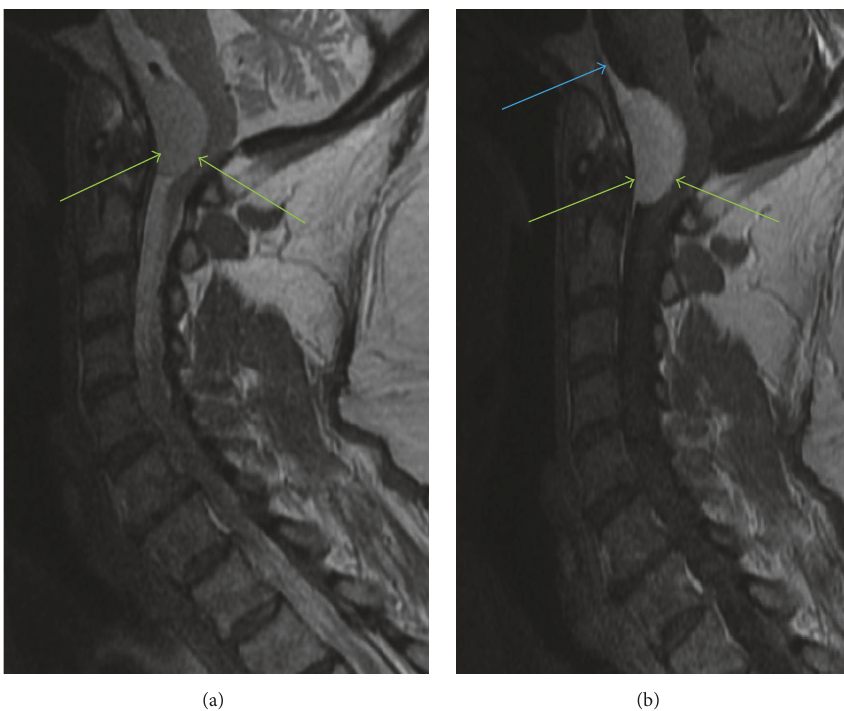
Figure 7: Sagittal T2WI (Figure 7(a)) and sagittal postgadolinium images (Figure 7(b)) show a homogeneously enhancing T2 hyperintense dural-based lesion (green arrows) representing a meningioma, occupying the anterior aspect of foramen magnum. This lesion demonstrates a characteristic dural tail (blue arrow) on postgadolinium image. This lesion causes effacement of anterior subarachnoid space and exerts mass effect resulting in posterior displacement of the adjacent medulla and upper cervical spinal cord with impingement at the level of foramen